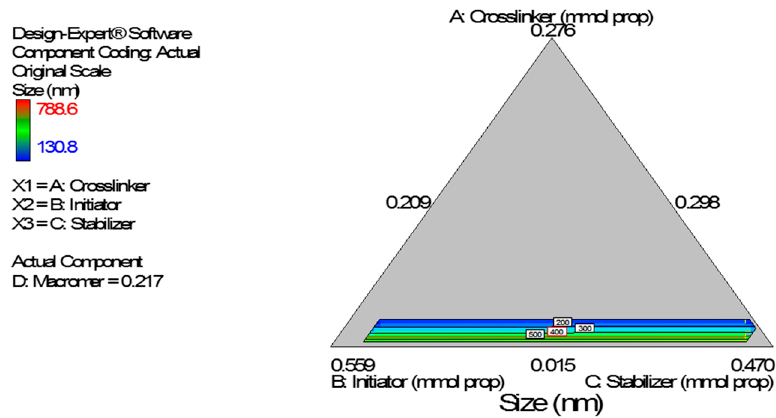
Figure 7. Model graph showing the design space and variation in particle size as a function of the mixture composition. A = Crosslinking agent; B = Initiators; C = Stabilizer and D = Macromonomer (poly- ε -caprolactone-based nanoparticles).